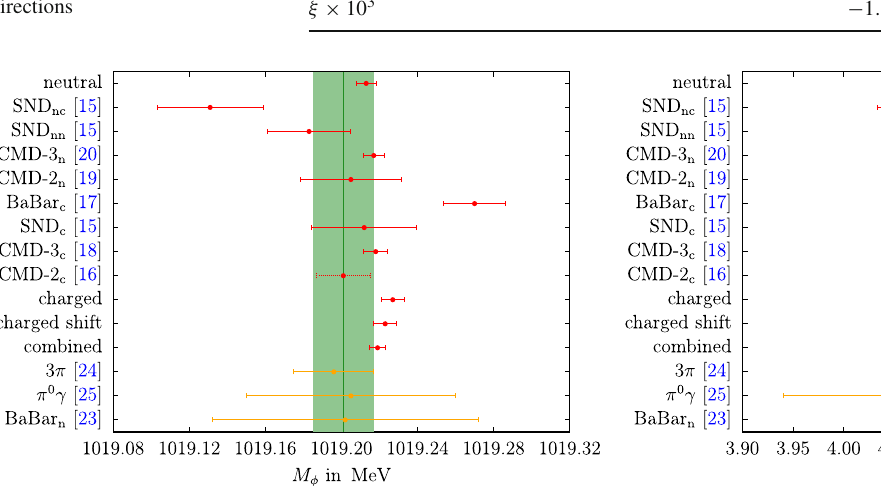
Table 1 Parameters for the fit variants 2 and 3 discussed in the main text. In the combined fit, the upper/lower values for c φ , c ω refer to the charged/neutral channel, respectively. The second bracket for c ω indicates the uncertainty induced by the UFD input, it is fully correlated with the corresponding variation in the isovector form factor and thus affects the neutral and charged residues in the opposite directions